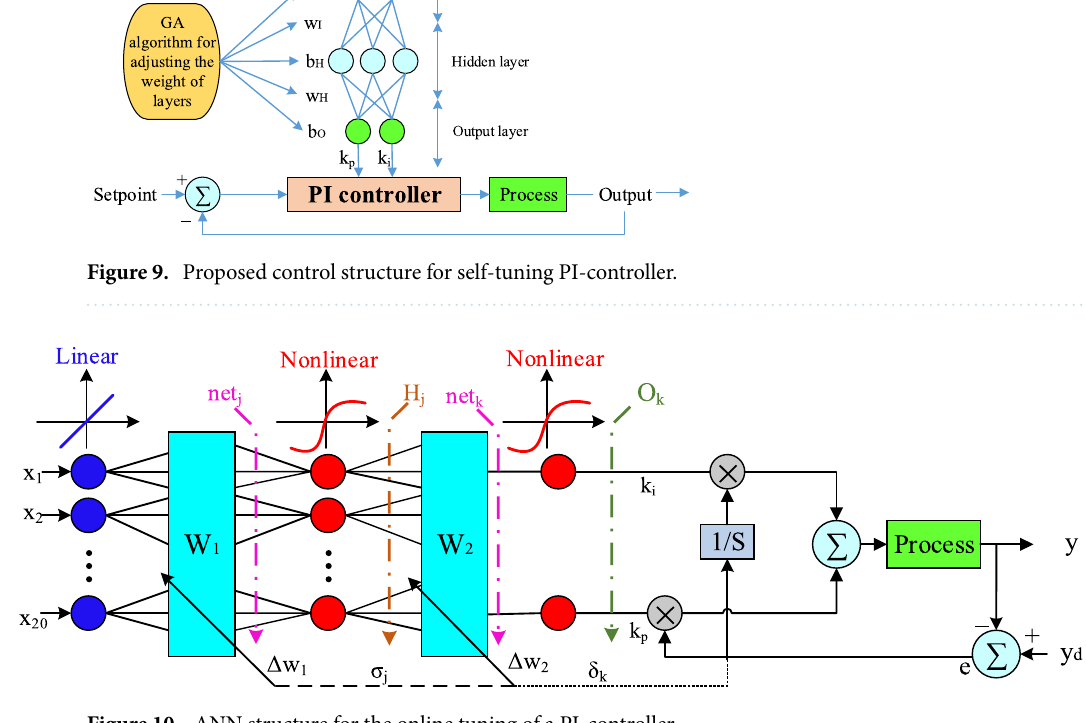
Figure 10. ANN structure for the online tuning of a